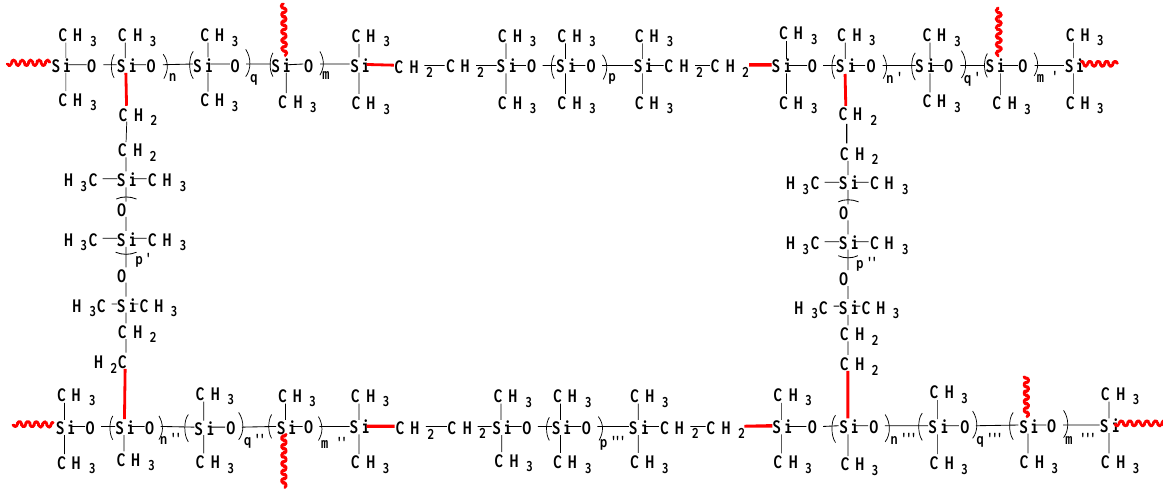
Scheme 1. The schematic cross-linking structure of SR. The red solid lines represent the bonds originating from the hydrosilylation reaction of vinyl with silicon hydrogen, and the wavy lines represent the chains of linear PDMS.